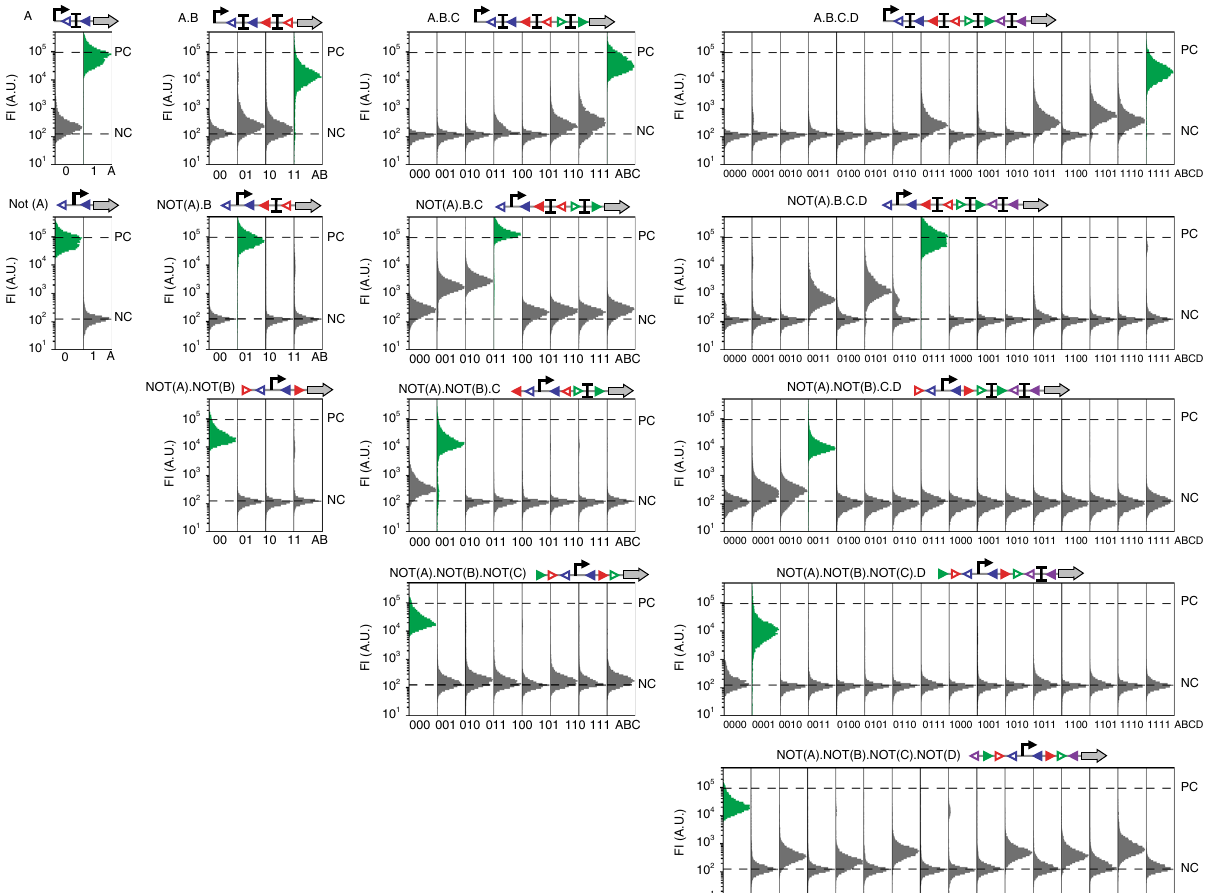
Fig. 4 Functional composition of logic elements into recombinase logic devices. For each device, we measured the fl uorescence intensity for each state by fl ow cytometry. Corresponding input states are on the x -axis (0: no input, 1: input). Green histograms correspond to the input states expected to be ON. Fluorescence intensity levels for the negative control (NC, no promoter) and positive control (PC, promoter-RBS-GFP) are represented by lower and upper dash lines, respectively. 2 experiments were performed in 2 different days with 3 replicates per experiment. A representative example is depicted here. Fold change measurements can be found in supplementary Fig. 5. Source data are provided as a Source Data fi